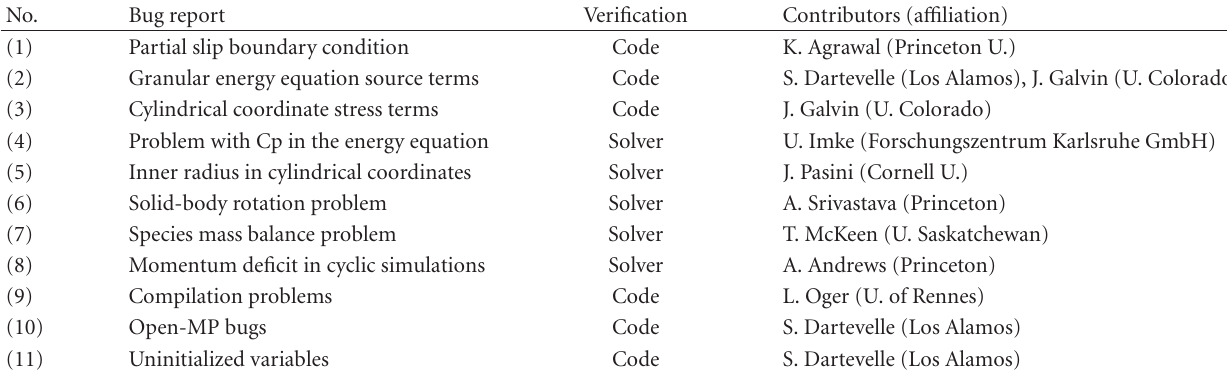
Table 4: MFIX bugs reported by